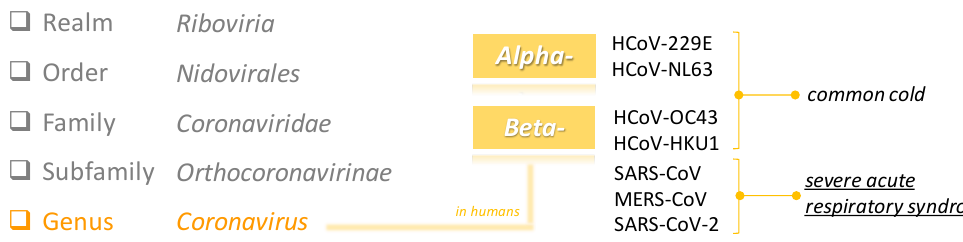
Figure 2. Taxonomy of coronaviruses (CoVs) affecting humans.